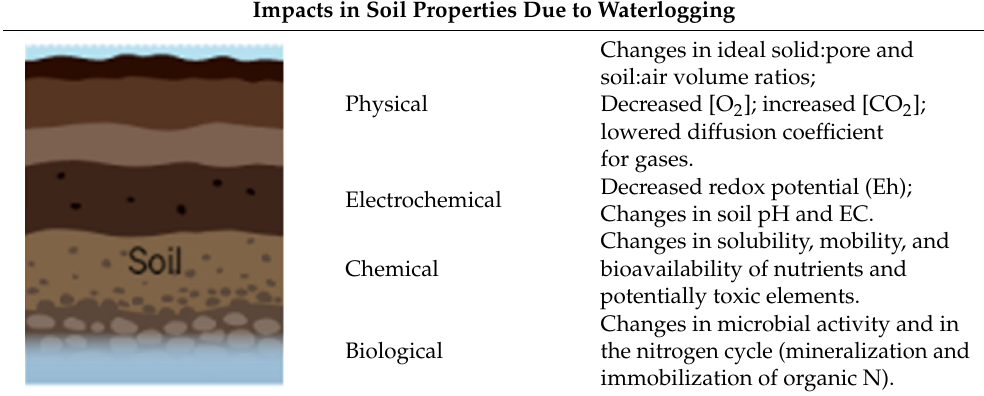
Table 1. Effects of waterlogging on the physical, electrochemical, chemical, and biological properties of the soil. Elements of the figure were created using biorender.com (accessed on 15 November 2022). Impacts in Soil Properties Due to Waterlogging